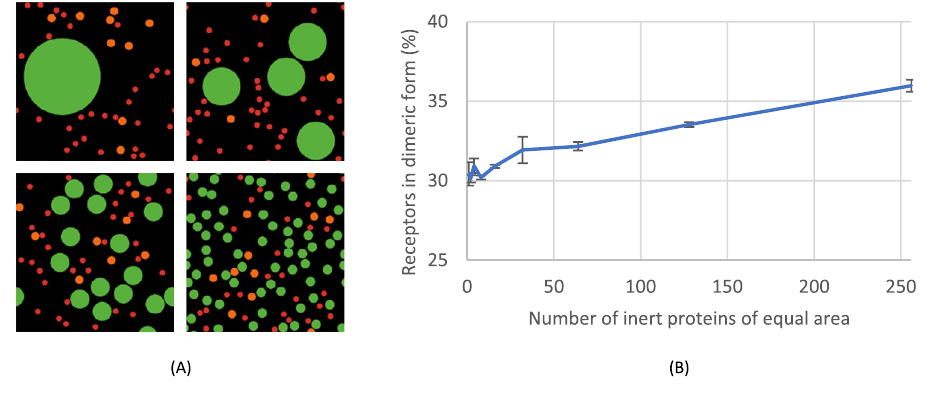
Figure 8. Disintegration of inert protein slightly affects receptor dimerisation. Simulation of the effect of size of inert proteins on receptor dimerisation. The total area occupied by inert proteins was kept constant, while subareas of smaller size were created. See further Fig. 5. ( A ) Snapshots for 1, 4, 16 and 64 splits of inert proteins. ( B ) Plot of receptor dimer counts versus the number of disintegrated inert proteins. Each simulation was repeated three times, mean ± SD (Pearson correlation + 0.96).